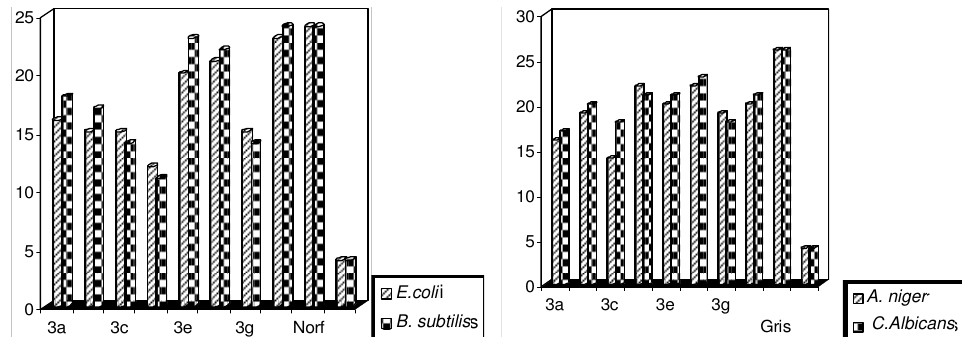
Figure 1. Antibacterial activity of synthesized compounds.